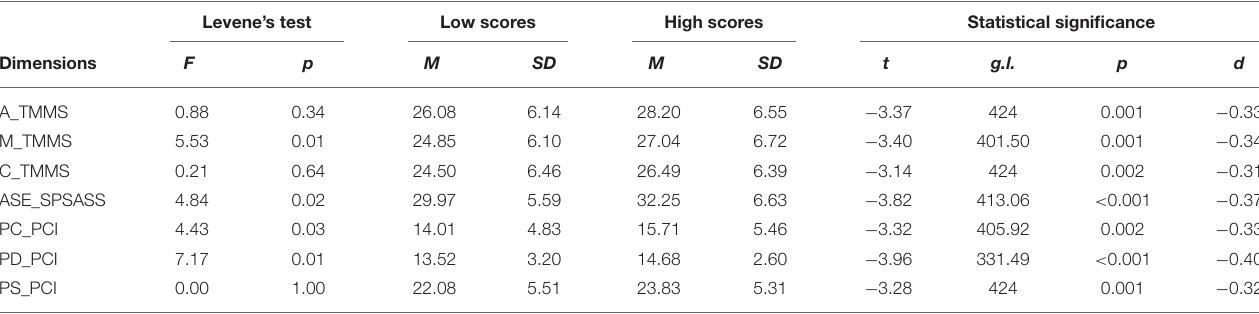
TABLE 1 | Differences in emotional intelligence, academic self-efficacy, and perfectionistic automatic thoughts in late adolescence according to high and low scores in aesthetic-musical awareness. Levene’s test Low scores High